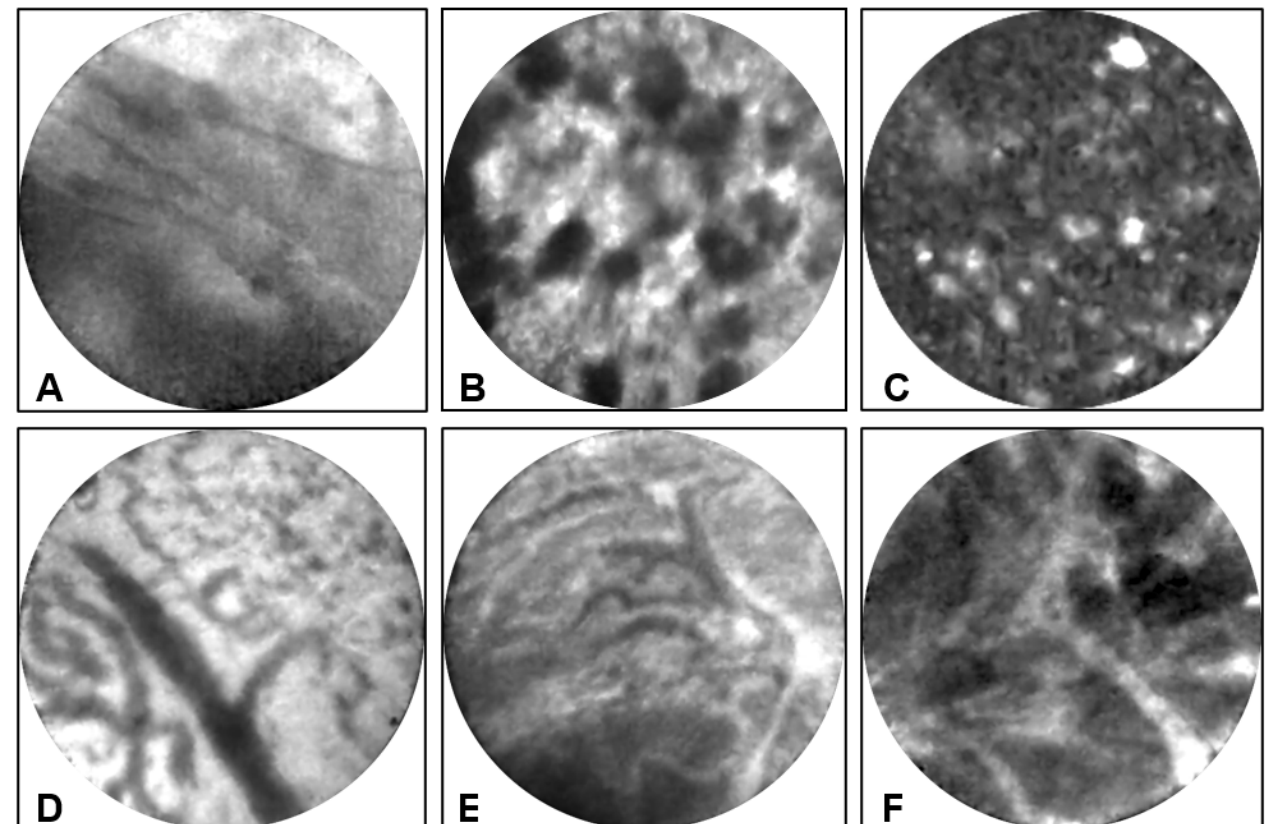
Figure 6. EUS-nCLE images of PCLs. ( A ) A mucinous cystic neoplasm revealing layering epithelial bands with thin epithelium in a lesion with low-grade dysplasia. ( B , C ) A pseudocyst revealing dark clumps of inflammatory debris ( B ) and a dark background ( C ) due to the absence of a vascular interstitium. ( D , E ) A serous cystadenoma demonstrating a fern-pattern of capillary network: The capillaries are packed with red blood cells ( D ) and partial contrast penetration highlighting the flow of red blood cells within the capillary network ( E ). ( F ) A cystic neuroendocrine tumor showing clusters of cells in geometric shapes (dark regions) separated by the stroma of the lesion.